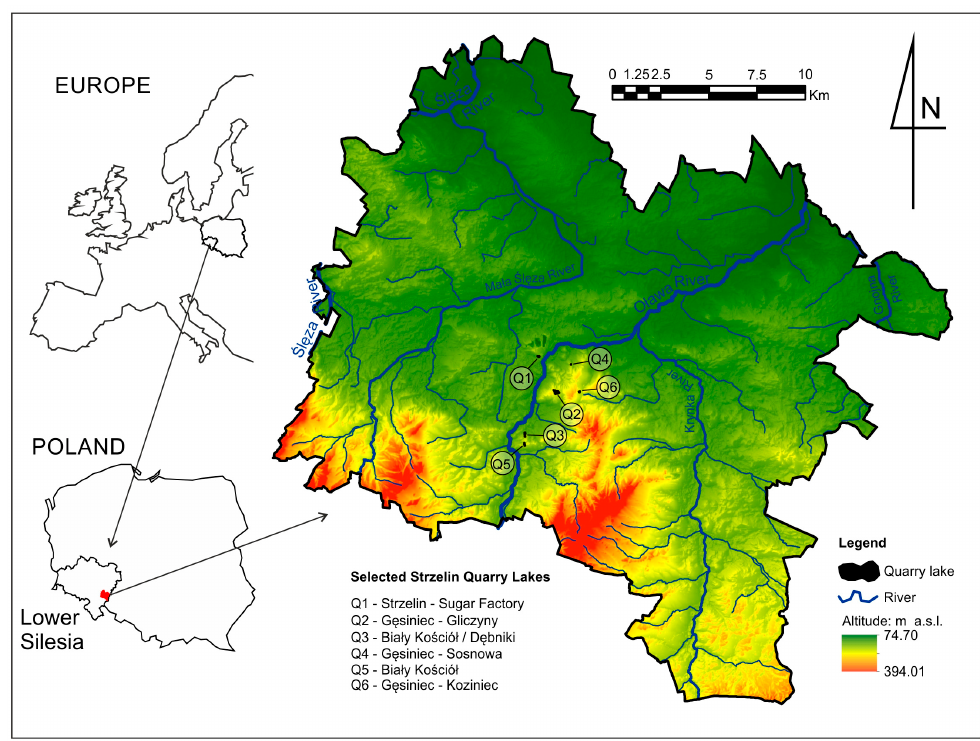
Figure 1. Position of the analysed quarries (DTM created by B. Jawecki [49], modified by the author B.J.).